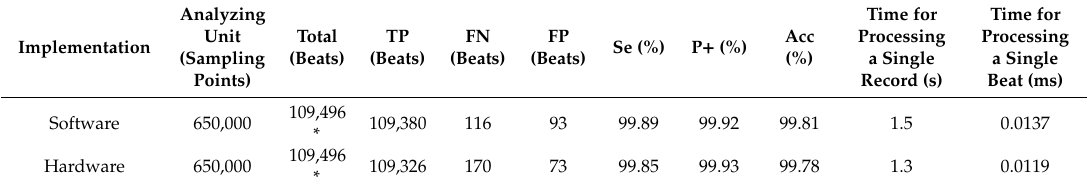
Table 4. R-peak detection performance comparison. Between software implementation and hardware implementation.